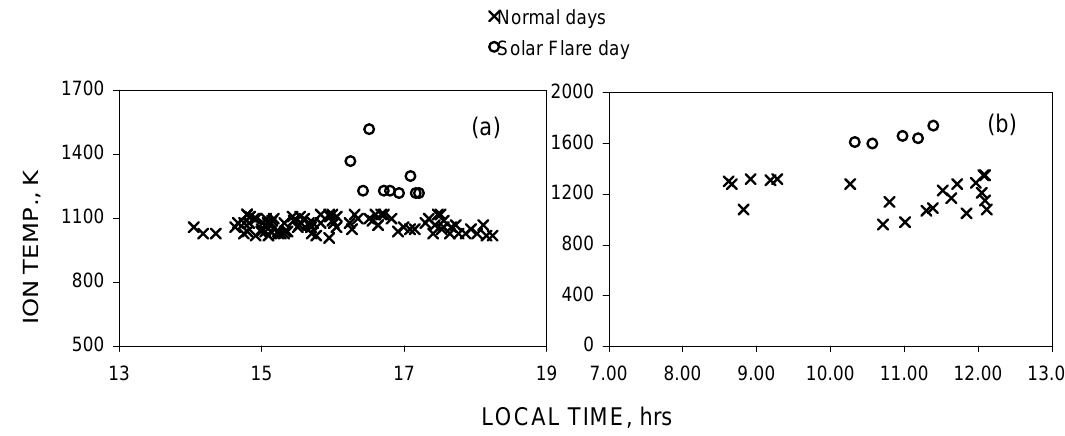
Fig. 4. Variation of ion temperature recorded by the SROSS-C2 satellite during solar flares and normal days at Panji.